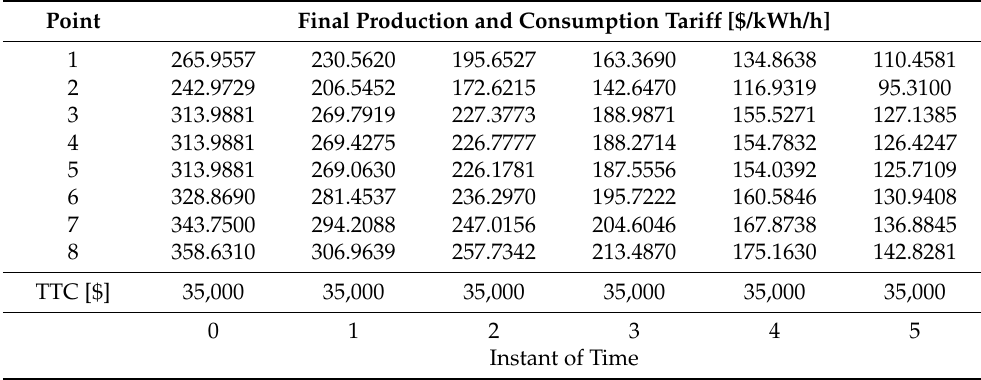
Table 8. Final production and consumption tariffs for each point and the total transportation cost between the instants of time 0 and 5 with W F = 0.25 and W B = 1.0. Point